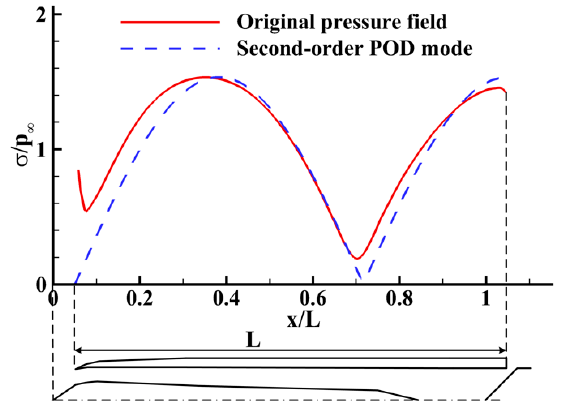
Figure 14. Standard deviation curve of static pressure inside the inlet.